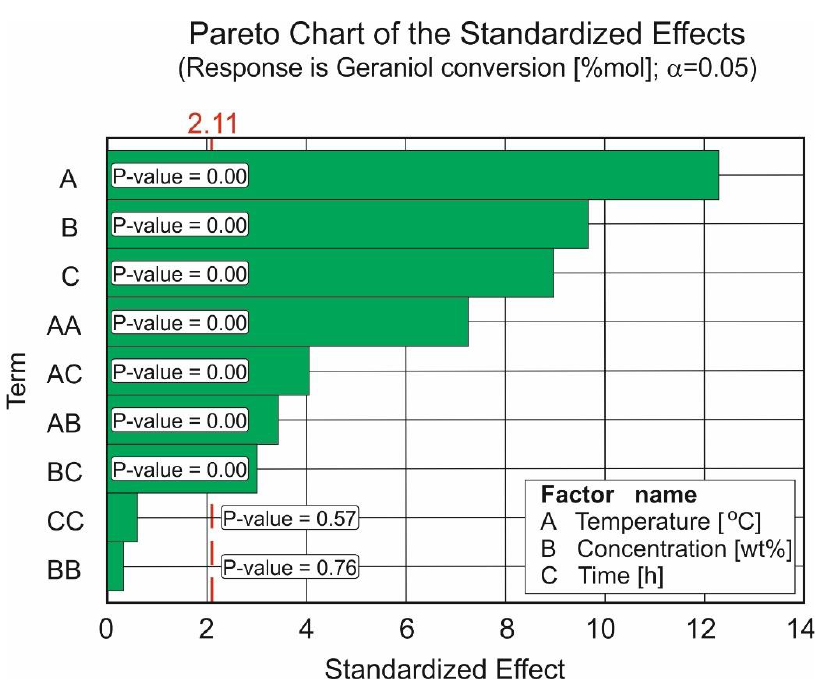
1. Hence, the model explained 94.3% of the variance of the data. In addition, differences between R 2 and R 2adj were lower than 0.2 for all the response variables, showing that the response surface accurately mirrors the data. The impact and correlation of each independent variable to the geraniol conversion was illustrated in a Pareto chart (Figure 1), constructed from the obtained regression polynomial equation (Equation (1)).